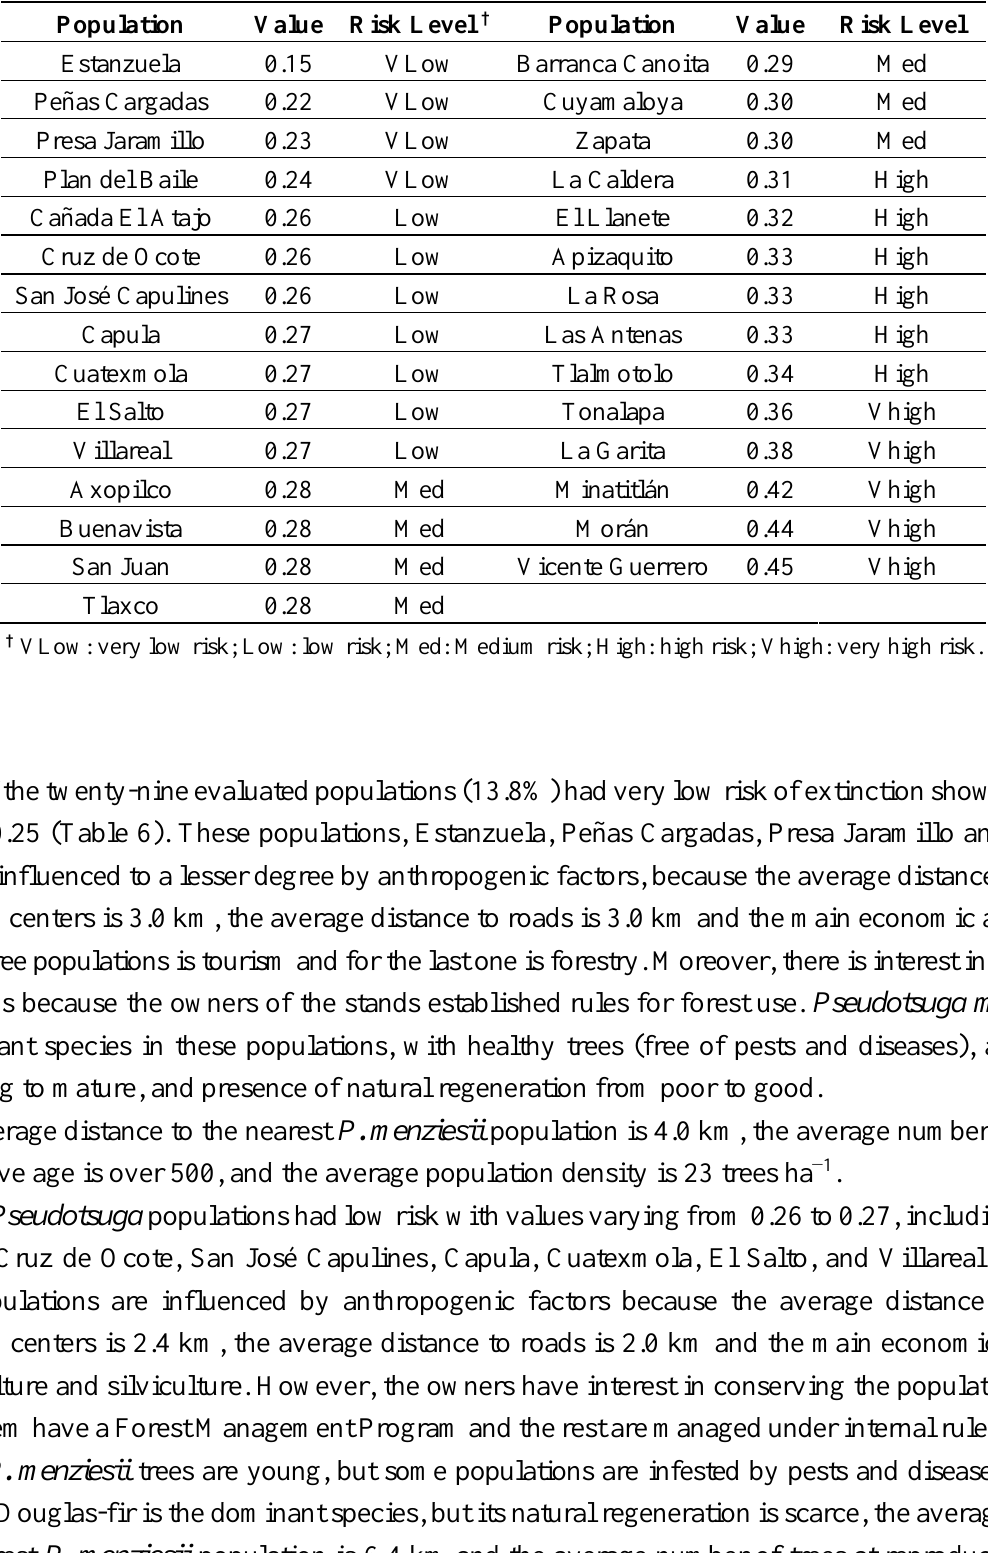
Table 6. Degree of risk of extinction for the Pseudotsuga menziesii populations in central